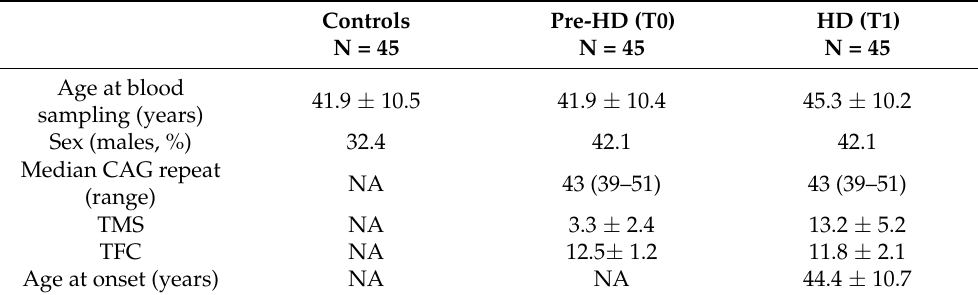
Table 1. Demographics of controls and HD patients at baseline (T0) and follow-up (T1). Values are expressed as mean ± SD. TMS: total motor score; TFC: total functional capacity; NA: not applicable.